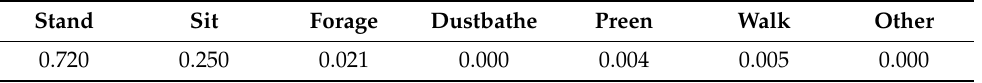
Table 3. Proportion of Hens, Overall Observations, Performing Each Behaviour on the Scratch